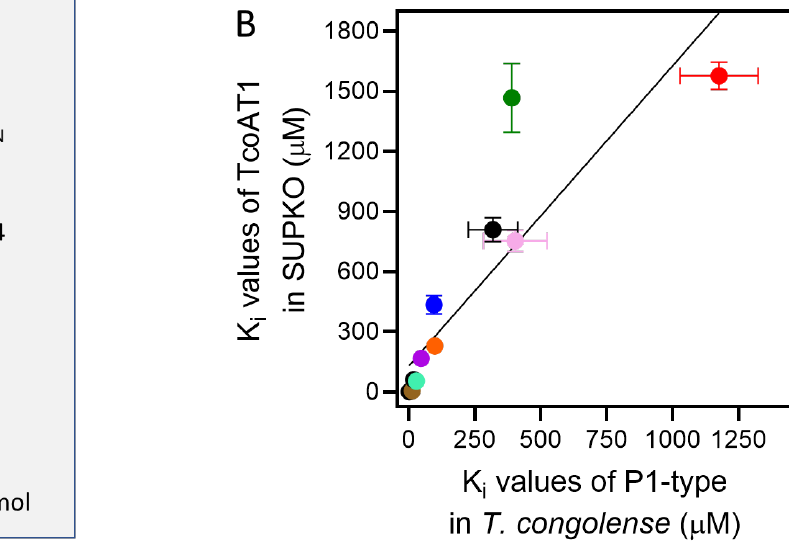
Figure 4. Model of adenosine uptake by TcoAT1. ( A ) Model for the interactions between adenosine and the TcoAT1 binding pocket, showing interactions at N3, N7 and 3′ -OH, with Gibbs free energy of interaction indicated in kJ/mol. The sum of these energies and the experimental value for the adenosine ΔG 0 is also indicated. ( B ) Correlation of K i values for nucleosides and nucleobases in T. congolense TcoAT1-type and TcoAT1 expressed in SUPKO. The K i values obtained for each substrate revealed a similar affinity trend for TcoAT1 in the parasite and when expressed in the SUPKO surrogate (r 2 = 0.78). Slope was significantly different from zero ( p < 0.0001 by F-test).